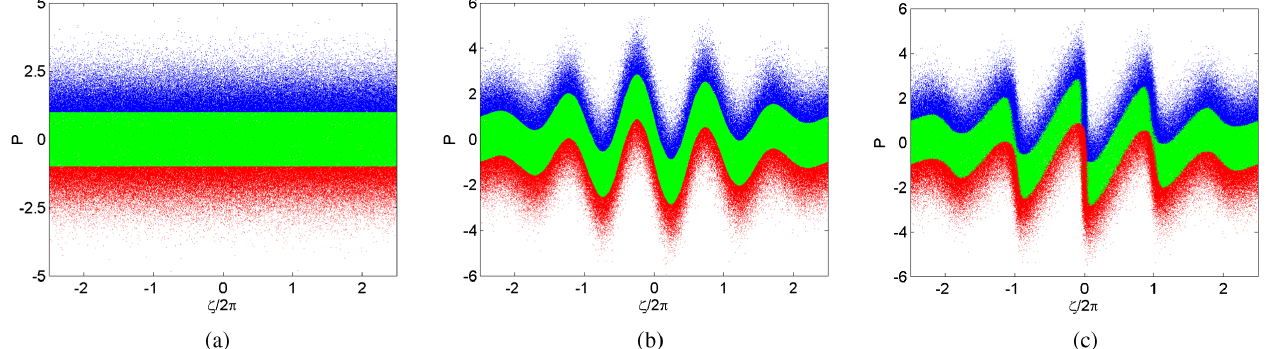
FIG. 2. Longitudinal phase space of the electron beam right after (a) the AD section, (b) the modulator section, and (c) the dogleg.